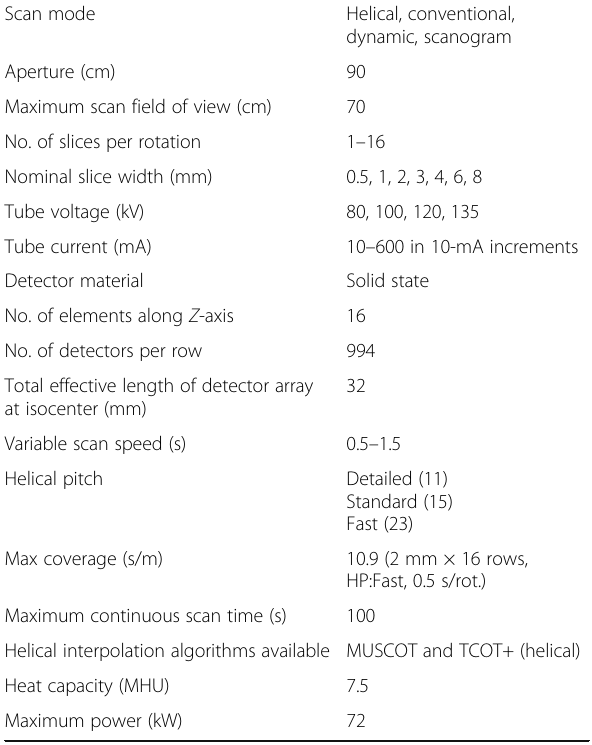
Table 1 Celesteion: major CT technical characteristics